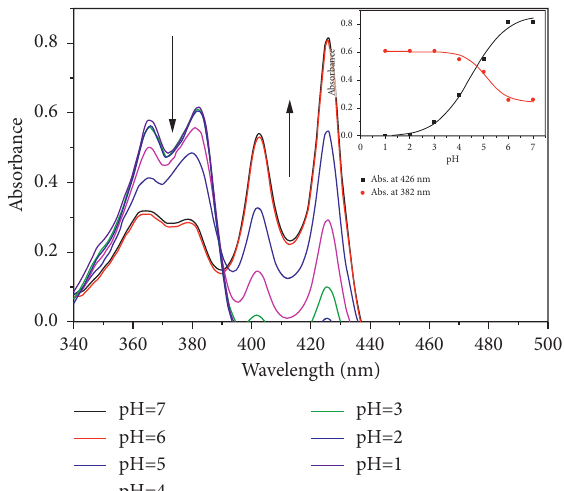
Figure 7: The electronic absorption spectra of 1 × 10 − 5 M for DDP dye at several pH values. The inset shows the plot of absorbance of 1 × 10 − 5 M for DDP dye versus